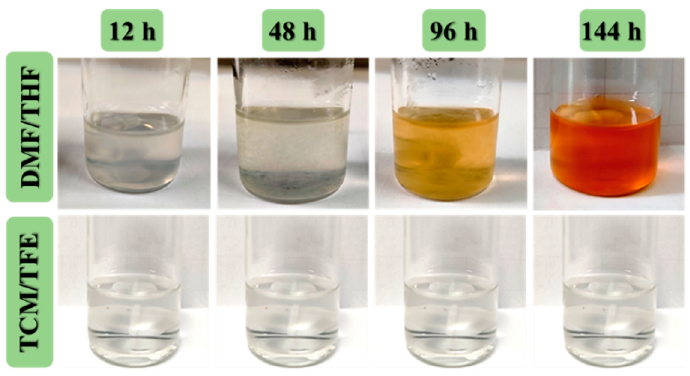
Figure 1. Stability of TPU (5% w / v ) solutions at different solvents.